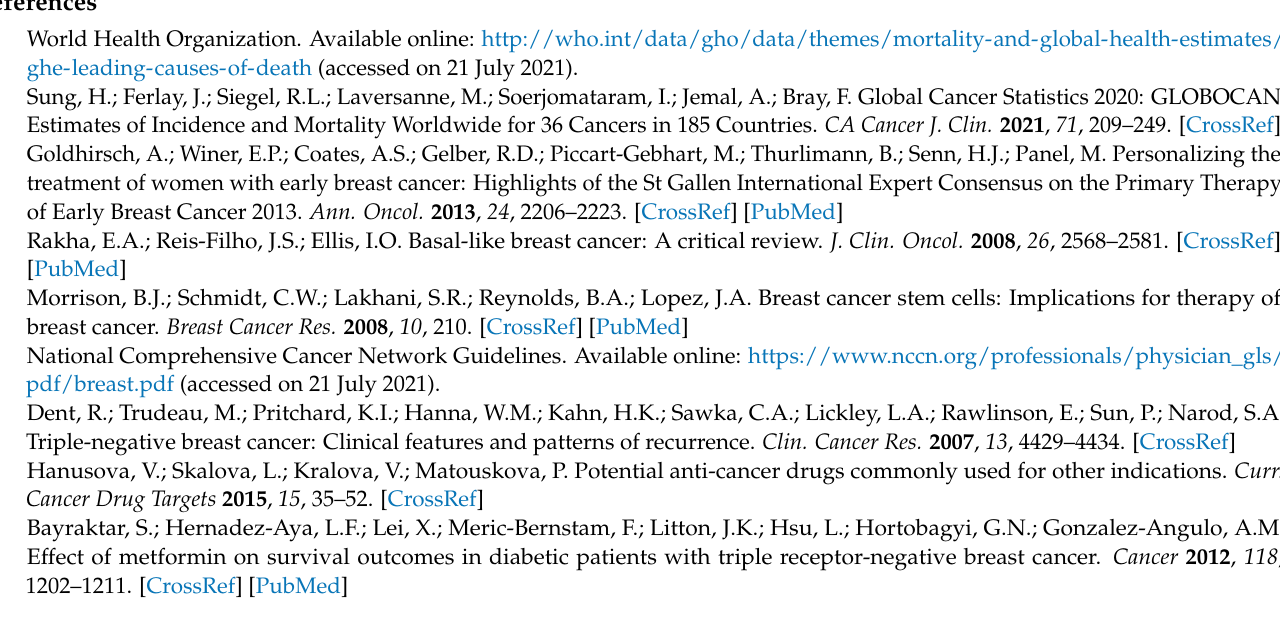
Western blot in Figure 6, Figure S1: The whole blot (uncropped blots) showing all the bands with all molecular weight markers on the Western in Figure 5b, Figure S2: The whole blot (uncropped blots) showing all the bands with all molecular weight markers on the Western in Figure 5c, Figure S3: The whole blot (uncropped blots) showing all the bands with all molecular weight markers on the Western in Figure 5d, Figure S4: The whole blot (uncropped blots) showing all the bands with all molecular weight markers on the Western in Figure 5e,f, Figure S5: The whole blot (uncropped blots) showing all the bands with all molecular weight markers on the Western in Figure